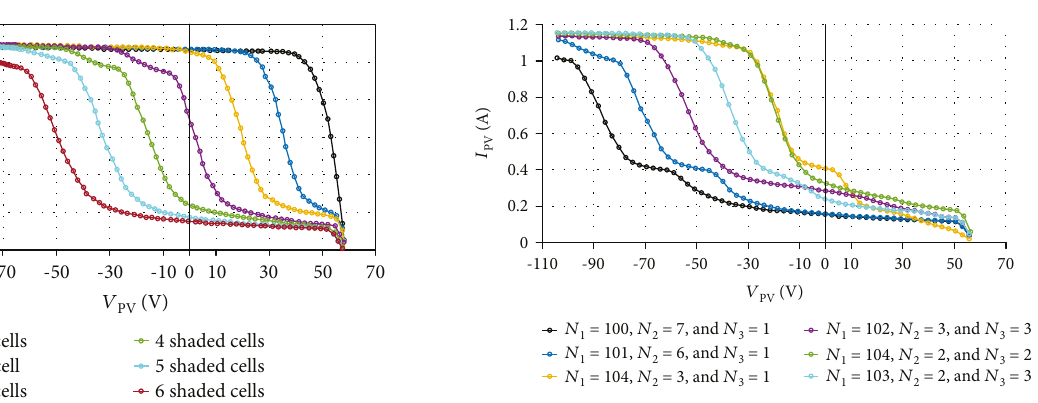
Figure 19: Full version (for both positive and negative voltages) of the I - V characteristics of the three series-connected PVUs with Figure 17: Full version (for both positive and negative voltages) of di ff erent numbers of shaded cells. 27 September 2017, Aversa the I - V characteristics of the three series-connected PVUs with a growing number of shaded cells. 27 September 2017, Aversa (CE), Italy. S 1 = 775W/m 2 characterizes the unshaded cells, and S 2 = 180 = 26 ° C . W/m 2 characterizes the shaded cells; T amb